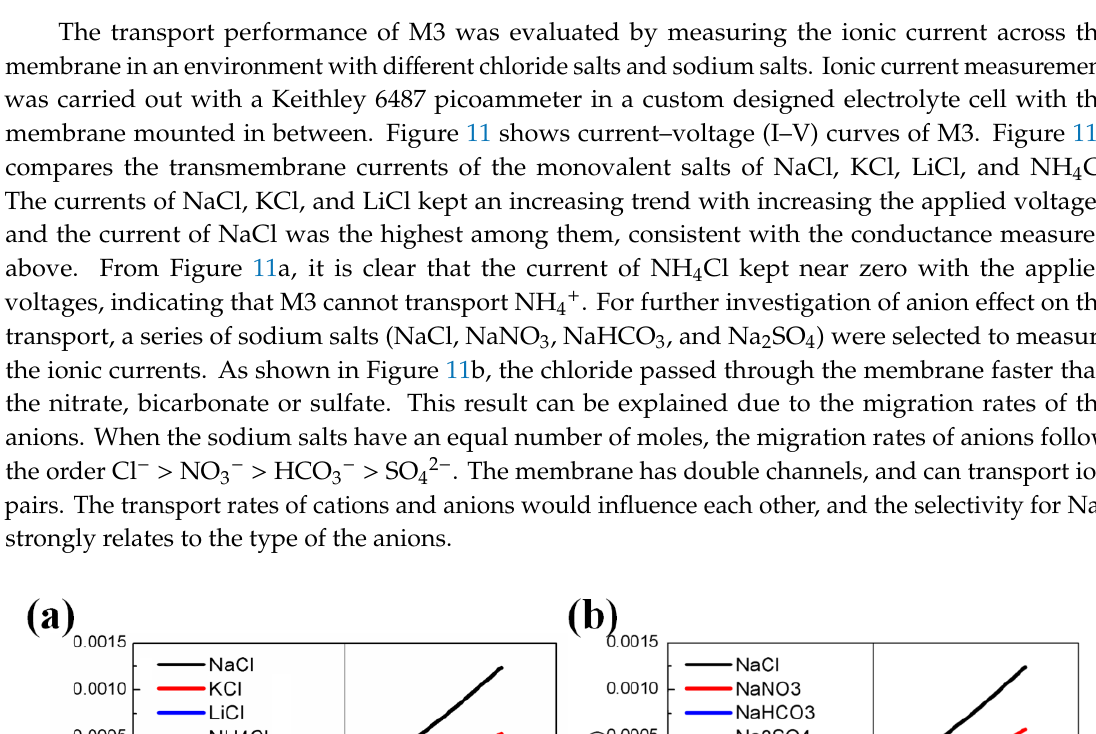
Figure 10. Aromatic cation- π and urea anion conduction pathways.